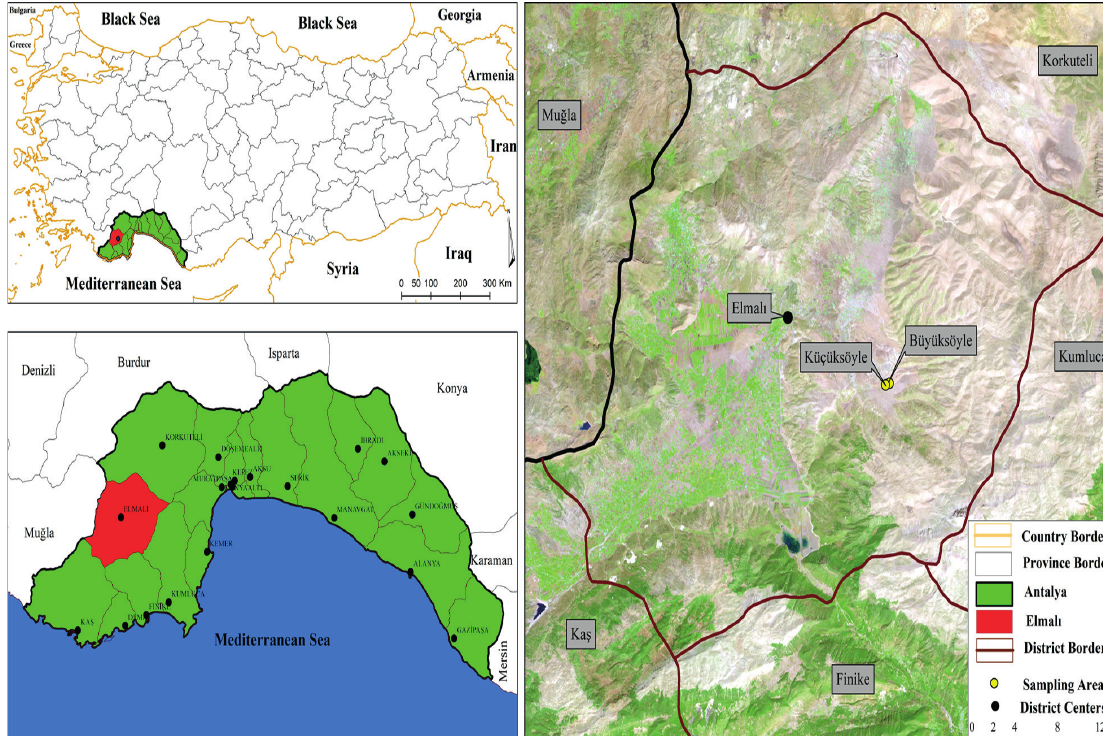
Figure 1 - Location map for cheese sampling (Antalya, Turkey) ( a ), Elmalı in Antalya ( b ), Küçük Söğle and Büyük Söğle villages in Elmalı ( c